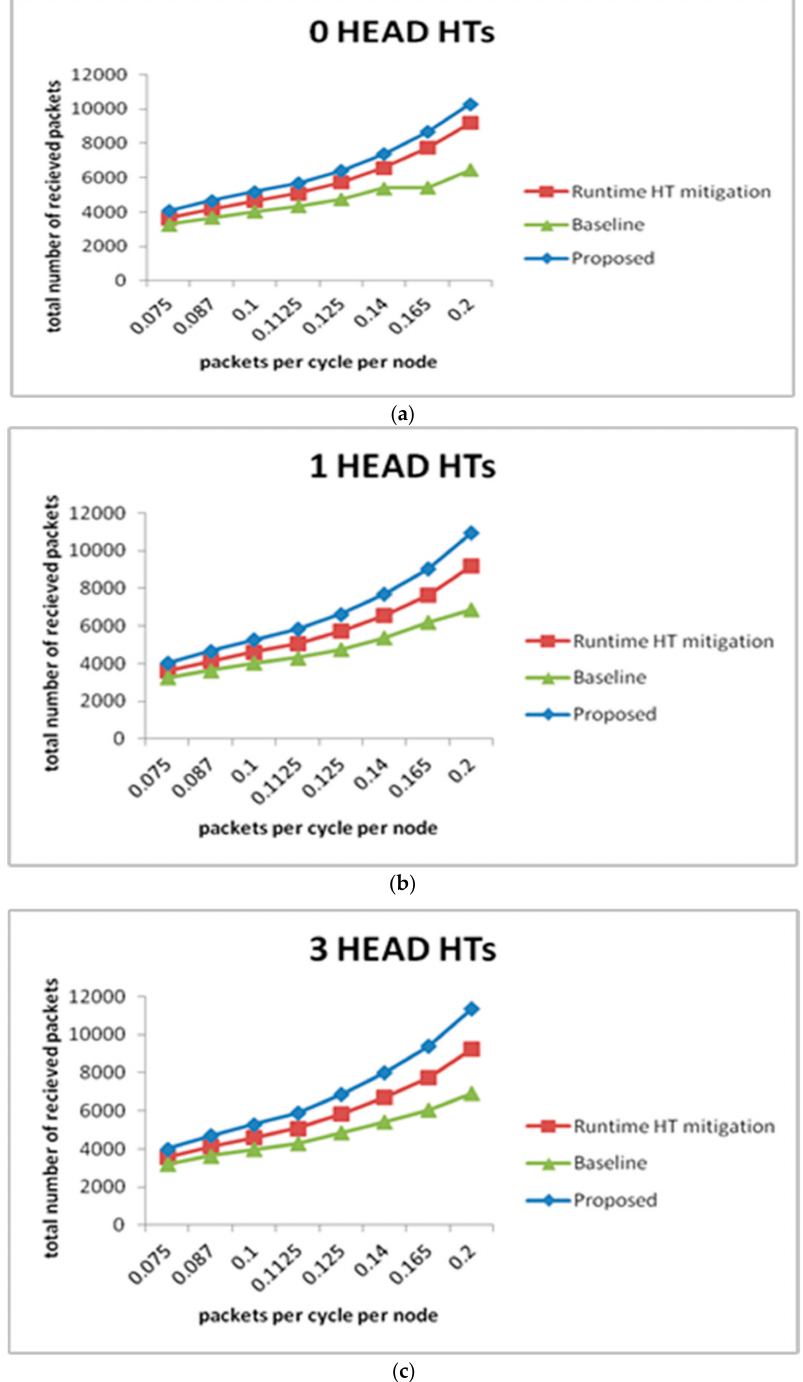
Figure 10. ( a ): No head HT. ( b ) One head HT. ( c ) Three head HTs. The packet’s tail flit is misrouted when the TAIL HT is present. Our proposed method has a good performance compared to the runtime HT mitigation method. Our method has 3% more received valid packets than the runtime HT mitigation method, as shown in Figure 11. The performance drop due to tail flit is more than that of the HEAD HT case. This is because when the tail flit is dropped, the packets will not release the network resource, which will have more effect on bandwidth